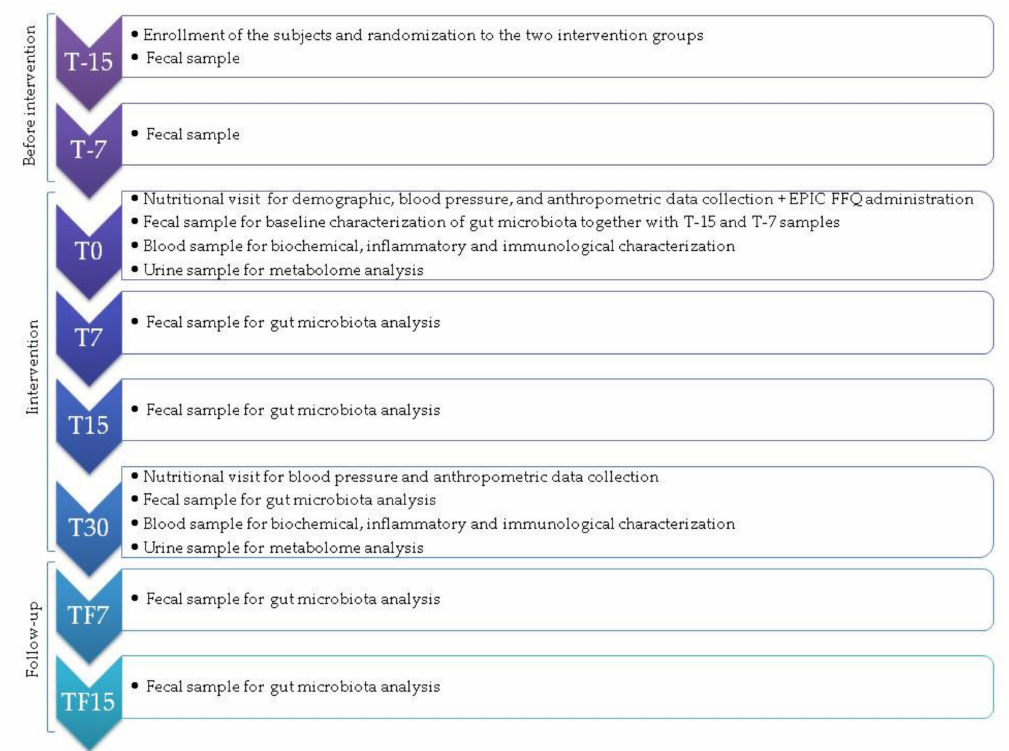
Figure 1. Study timeline. Italy, 2018–2019. The time points are grouped as follows: (i) T-15 and T-7: 15 and 7 days before the intervention (Before intervention); (ii) T0: start of the intervention; T7, T15 and T30: 7, 15 and 30 days from the beginning of the intervention (Intervention); and (iii) TF7 and TF15: 7 and 15 days after the end of the intervention (Follow-up). The validated semi-quantitative European Prospective Investigation into Cancer and Nutrition (EPIC) Food Frequency Questionnaire (FFQ) was administered to collect information on consumption frequency of food